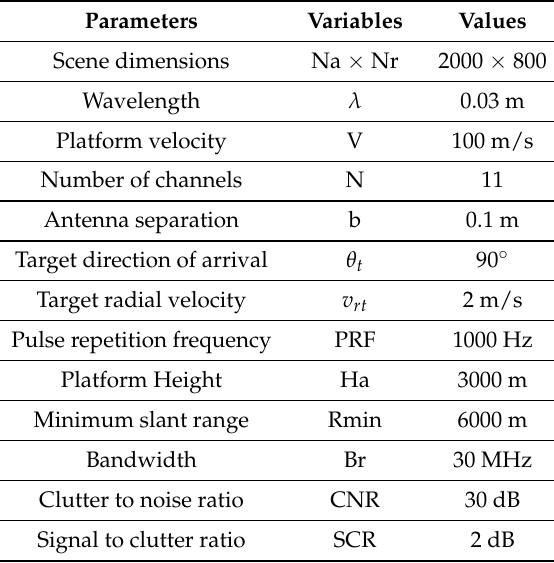
Table 2. System and geometry parameters.